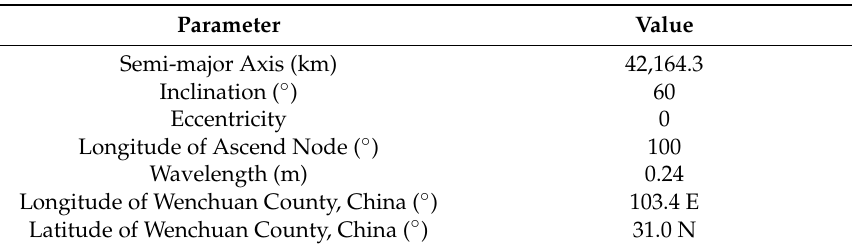
Table 1. Simulation parameters.